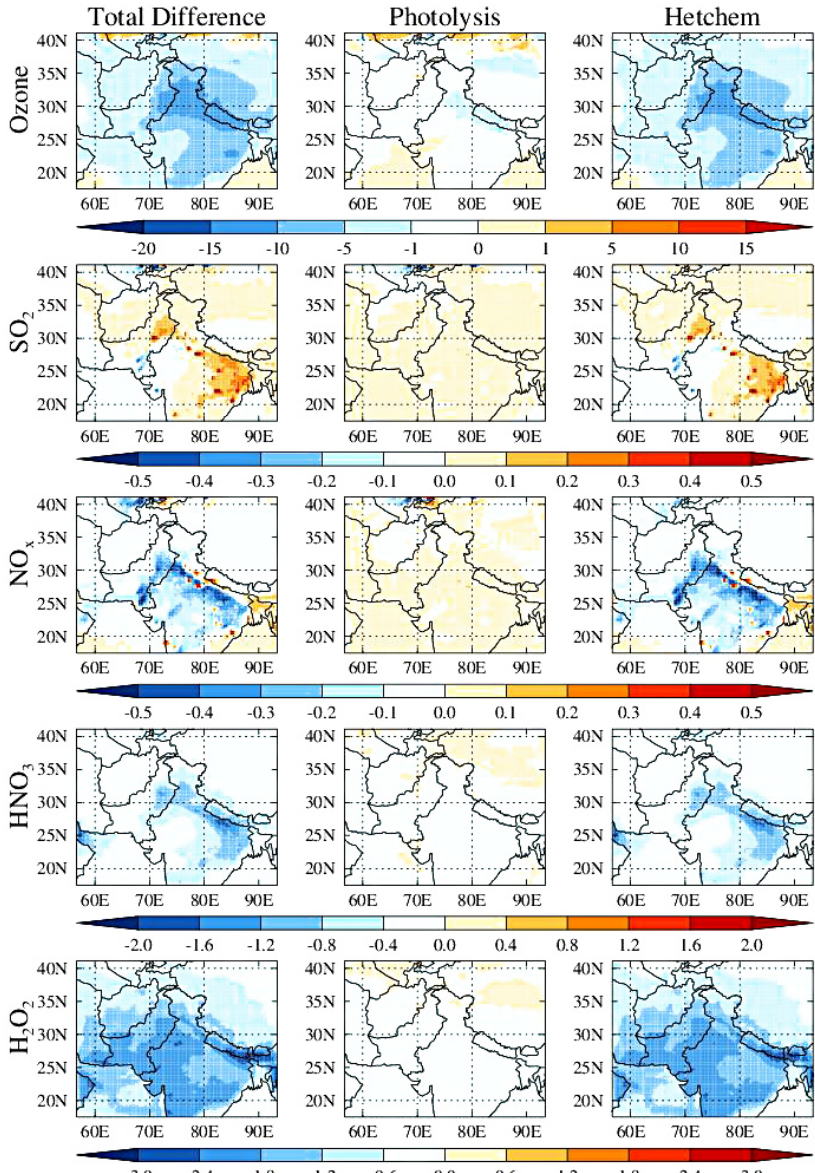
Figure 6. Spatial distributions of absolute difference in average O 3 , SO 2 , NO x , HNO 3 and H 2 O 2 between Dust_JH and No_Dust (left panel), Dust_J and No_Dust representing the contribution of photolysis to total difference (middle panel), and Dust_JH and Dust_J representing the contribution of heterogeneous chemistry to total differences (right panel). All values are in ppbv and for the surface layer of the